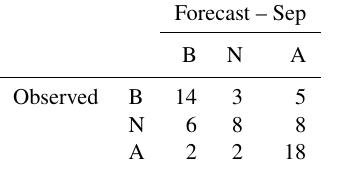
Table 3. September Stat-PCR model categorical streamflow results: observed vs. forecast.